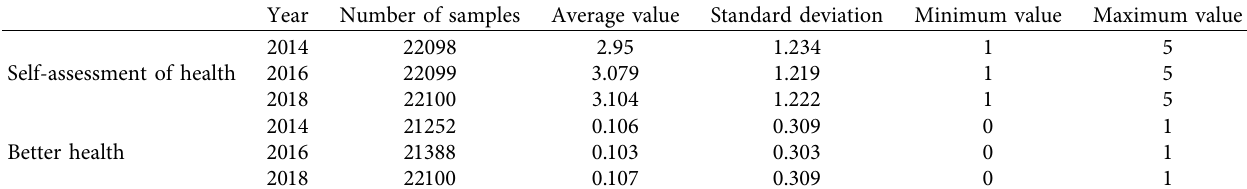
Table 2: Health of the population.